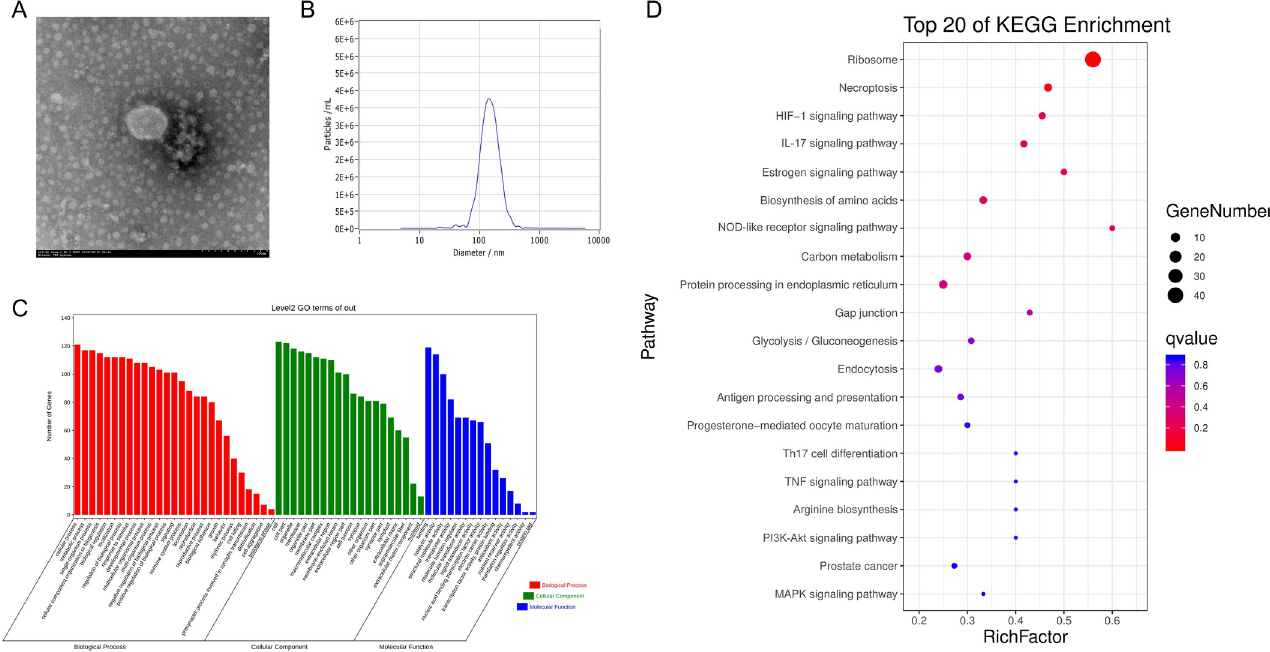
Fig 1. Characterization and proteomic analysis of G . duodenalis extracellular vesicles. (A) Morphological observation of GEVs using negative staining by TEM. Typical rounded or cup-shaped vesicles were obtained. Scale bar: 200 nm. (B) Nanoparticle tracking analysis of purified GEVs. The concentration and diameter detection of GEVs using Nanosight. The mean diameter and concentration were measured. (C) Gene ontology annotations for all the identified proteins in GEVs. (D) Top 20 of KEGG enrichment in GEVs.